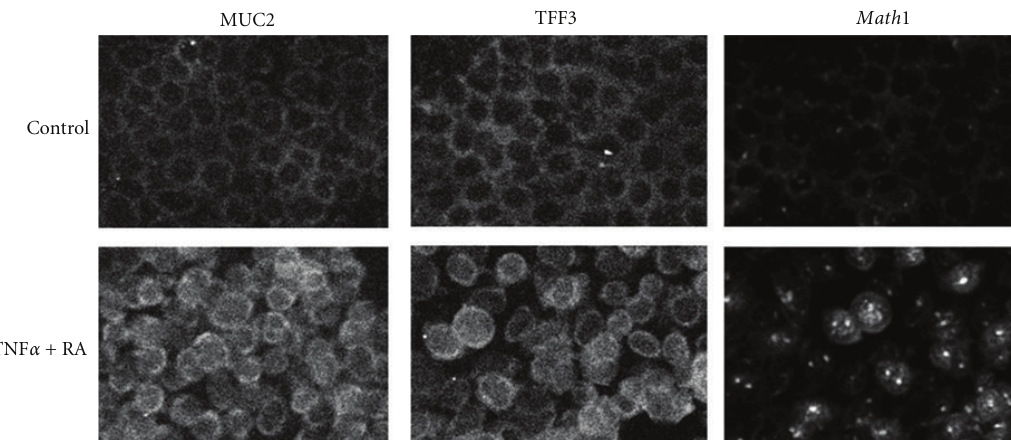
Figure 4: Mouse middle ear epithelial cells were incubated with 20ng/mL of TNF α and 10 − 9 M of RA for two weeks on 8-well chamber slides (media and factors were supplied every two days). Immunohistochemistry showed that these factors increased the expression of goblet cell markers, MUC2 and TFF3, suggesting that this could be a model of mucous cell metaplasia in infectious otitis media. Math1 was located only in the cytoplasm in the control culture, however, the administration of TNF α + RA made Math1 translocate into nuclei. This Math1 activation (translocation to nuclei) probably triggers the expression of MUC2 and